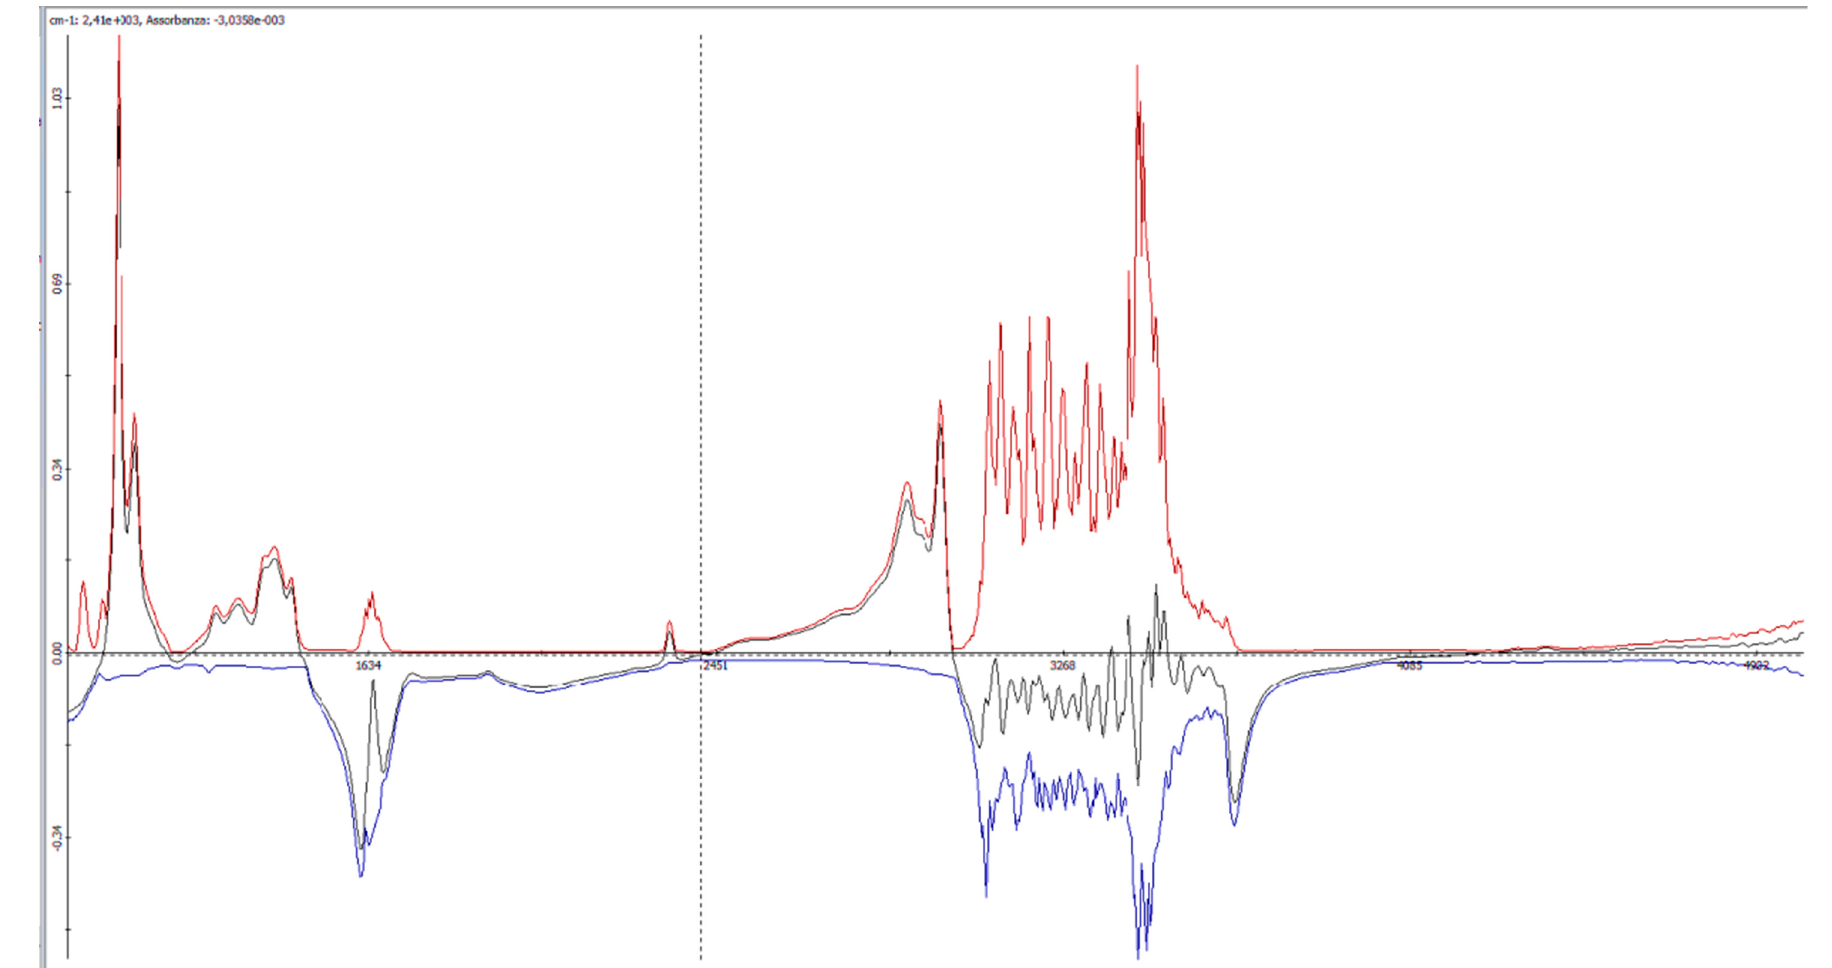
Figure 1. Ischia DOC Piedirosso or Per’e Palummo wine total spectrum.